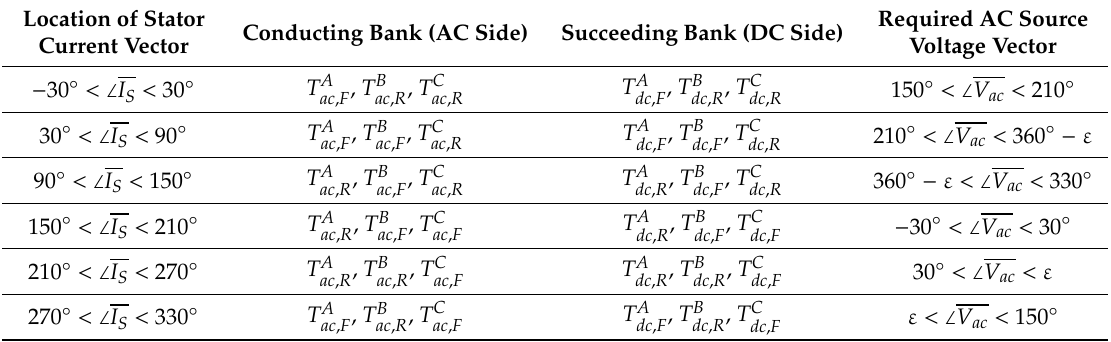
Table 4. Classification of outgoing AC-side and incoming dc side SCRs for an AC to DC